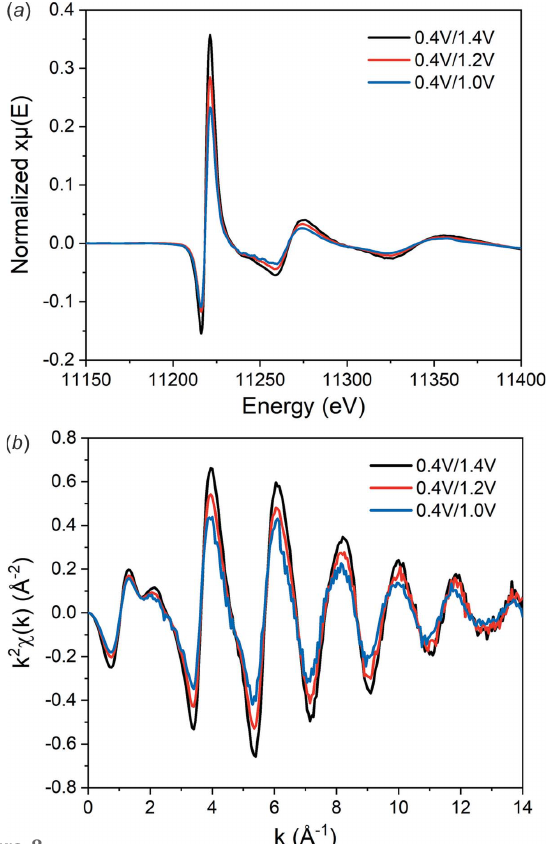
Figure 8 Comparison of the demodulated spectra of different modulation conditions in E -space ( a ) and k -space ( b